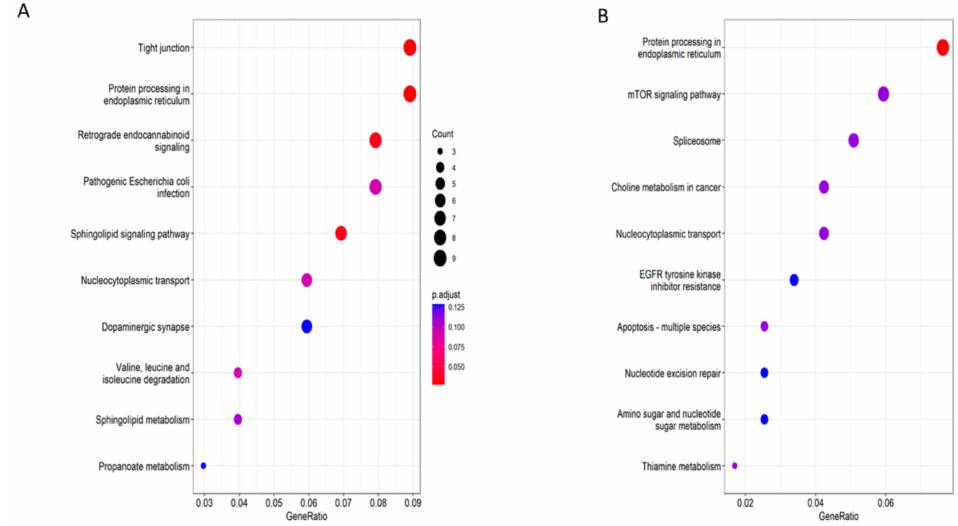
Figure 5. Visualization of KEGG pathway enrichment for alternative splicing events, especially exon skipping in two groups, ranked with inclusive difference value. ( A ) Enrichment results of exon skipping event with 10 significant terms (adjusted p -value < 0.05) in ( A ) cryoprotectant-free vitrified spermatozoa group and ( B ) conventionally frozen spermatozoa group.